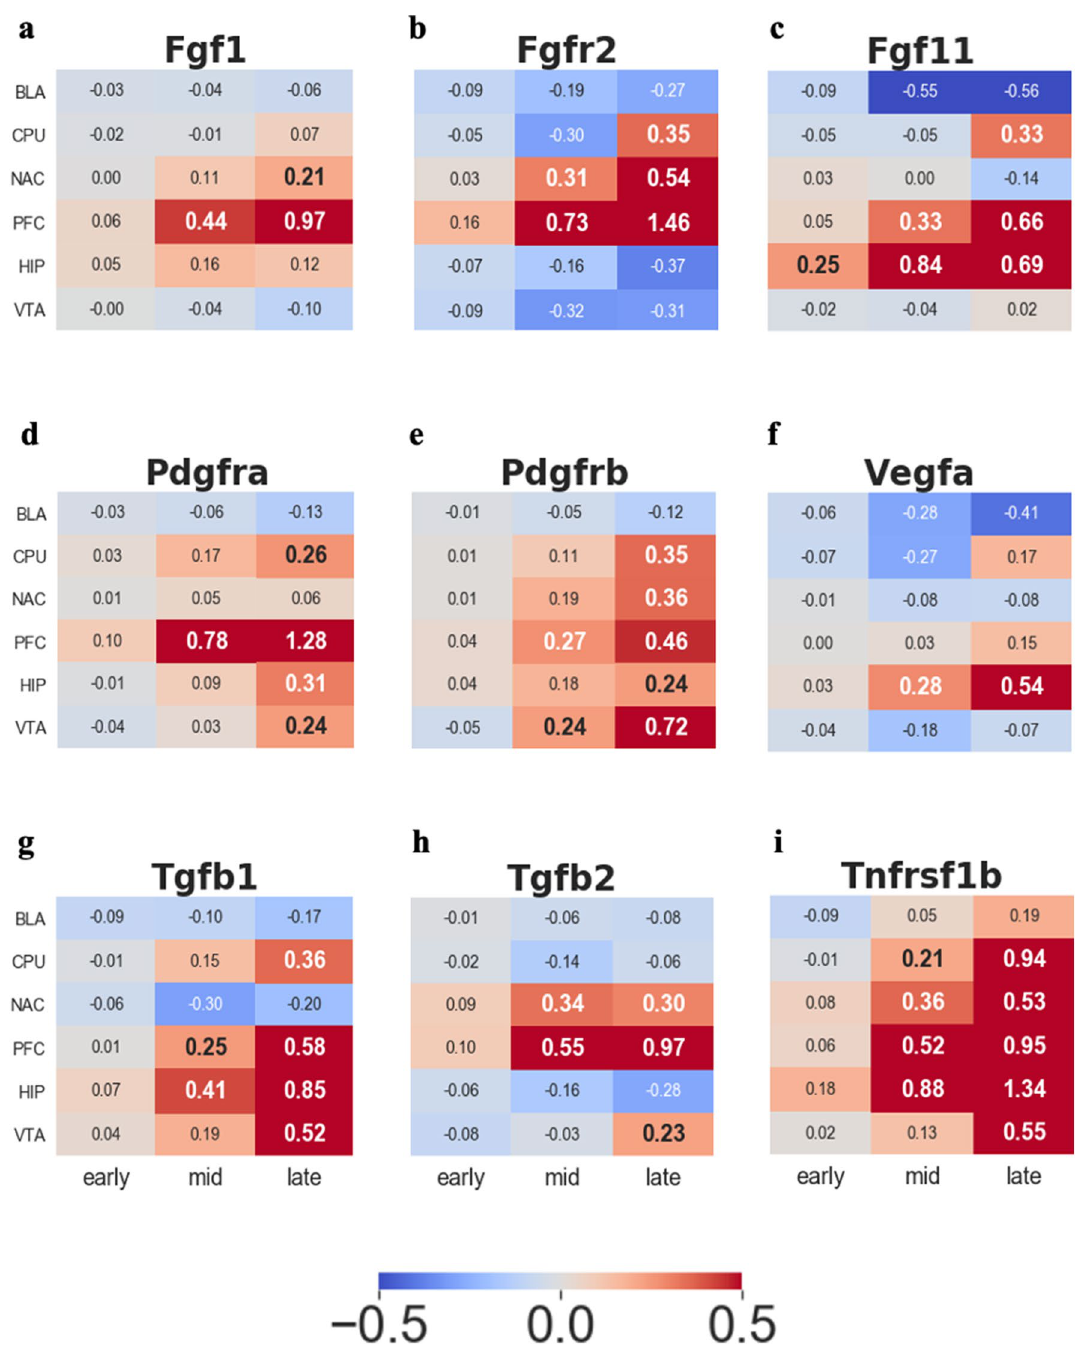
Figure 5. Log2FC trend for angiogenesis-related genes. ( a ) Fibroblast growth factor 1 ( Fgf1 ) ( b ) Fibroblast growth factor receptor 2 ( Fgfr2 ) ( c) Fibroblast growth factor 11 ( Fgf11 ) ( d ) Platelet-derived growth factor receptor A ( Pdgfra ) ( e ) Platelet-derived growth factor receptor A ( Pdgfrb ) ( f ) Vascular endothelial growth factor A ( Vegfa ) ( g ) Transforming growth factor beta 1 ( Tgfb1 ) ( h ) Transforming growth factor beta 2 ( Tgfb2 ) ( i ) Tumor necrosis factor receptor 2 ( Tnfr2